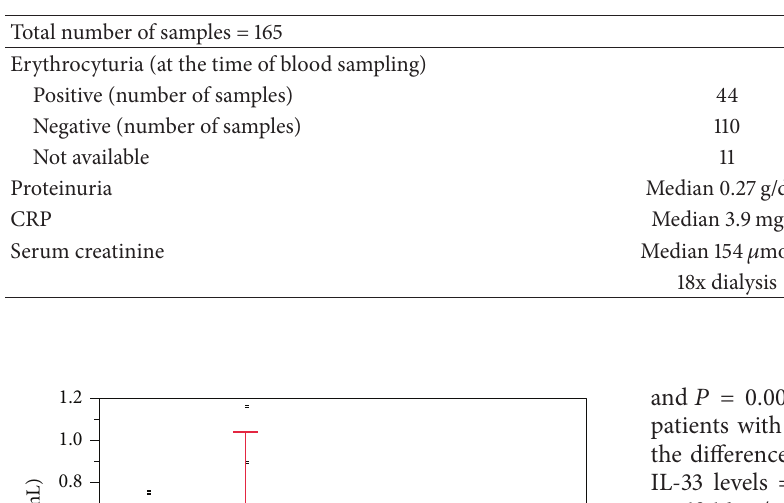
Table 2: Laboratory characteristics.